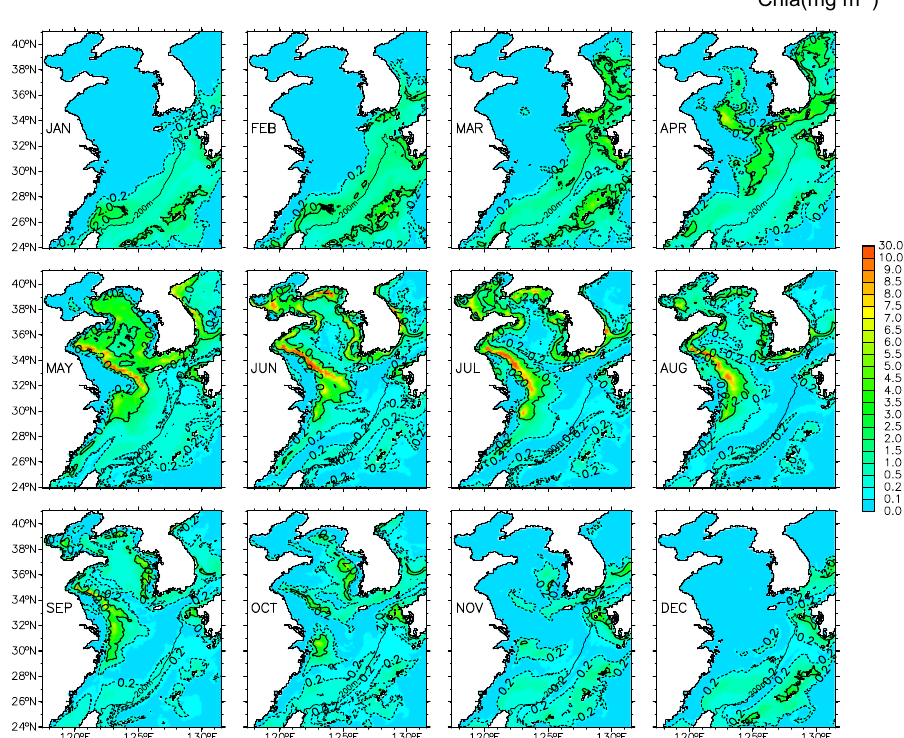
Fig. 5. Horizontal distribution of simulated chlorophyll a (mgm − 3 ) at the surface layer (2m depth) in 12